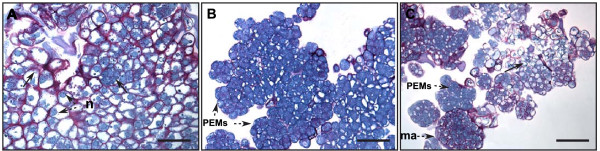
Histological appearance of coffee embryogenic callus cultures as a function of the age of the culture. Primary embryogenic callus produced on leaf explants; note the heterogeneous structure where degenerating (arrow) and active areas co-exist; the cells are characterized by a small non-central nucleus and low starch and cytoplasm soluble protein contents, scale bar = 36.5 μM (A). Seven-month-old embryogenic callus culture; note the highly homogeneous structure mainly comprising proembryogenic masses (PEMs) whose cells exhibit a high nucleus cytoplasm ratio and dense cytoplasm rich in soluble and reserve proteins, scale bar = 73 μM (B). Twenty-six month-old embryogenic callus culture; note the heterogeneous appearance of the mix of isolated cells, degenerating areas (arrow), masses oriented towards somatic embryogenesis (ma), along with areas of cells with protein rich cytoplasm (PEMs) similar to those in younger embryogenic cultures, scale bar = 73 μM (C).